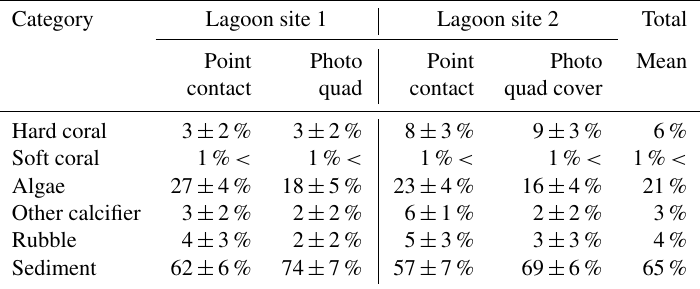
Table 1. Percent cover (mean ± SD) measured during point-contact and photo-quadrat surveys. Data for point contact surveys were pooled across triplicate transects and repeated survey efforts ( n = 6 per site) within each lagoon site area. Data for photo-quadrat surveys were pooled across triplicate transects and repeated survey efforts within each lagoon site area ( n = 360 per